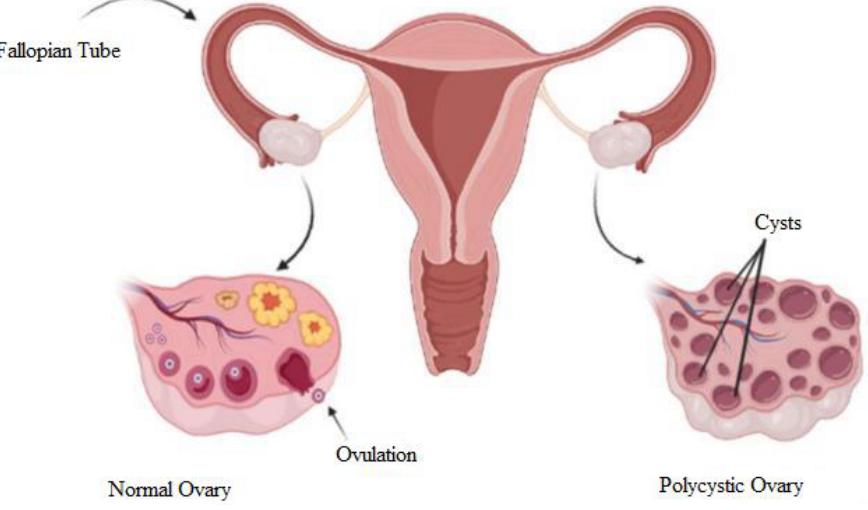
Figure 1. Diagram of normal and polycystic ovaries [12].